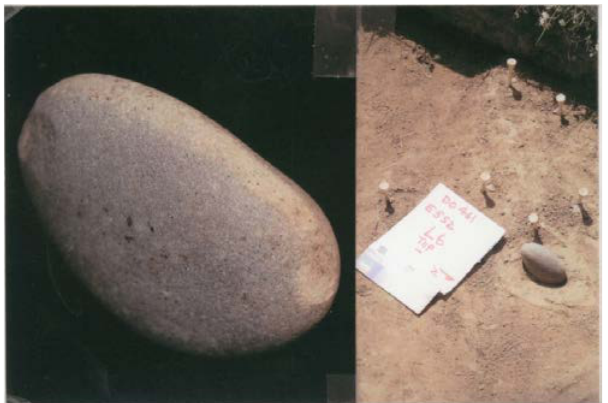
Figure 17. A small pecking hammer recovered at the top of level 6 at the Hensler with the hammerstone. Photo by